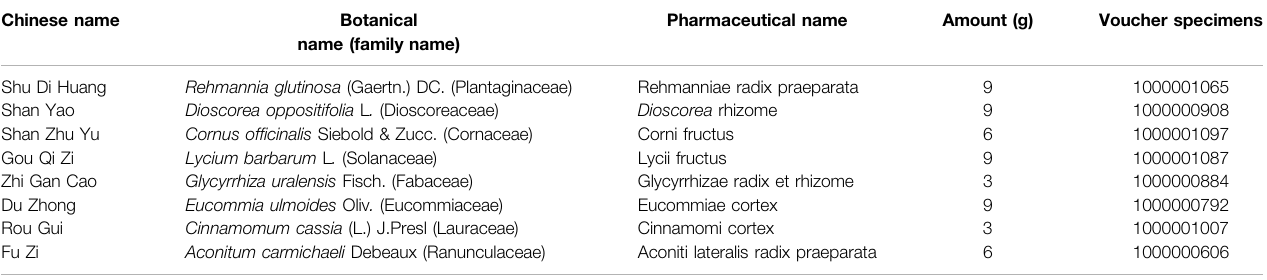
TABLE 2 | The herbal composition of Yougui.